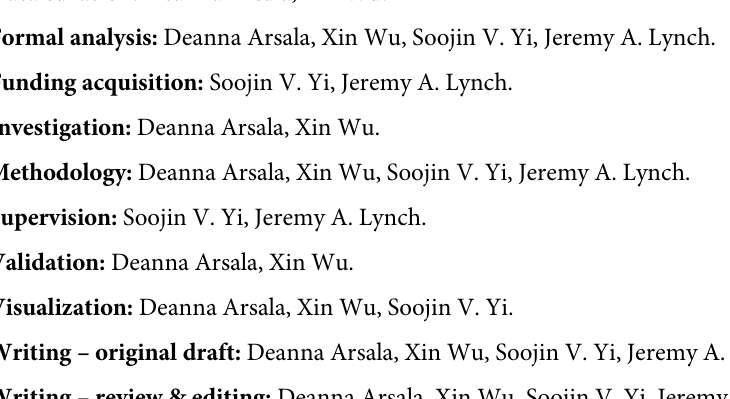
S4 Table. Primer sequences for Nv-dnmt1a